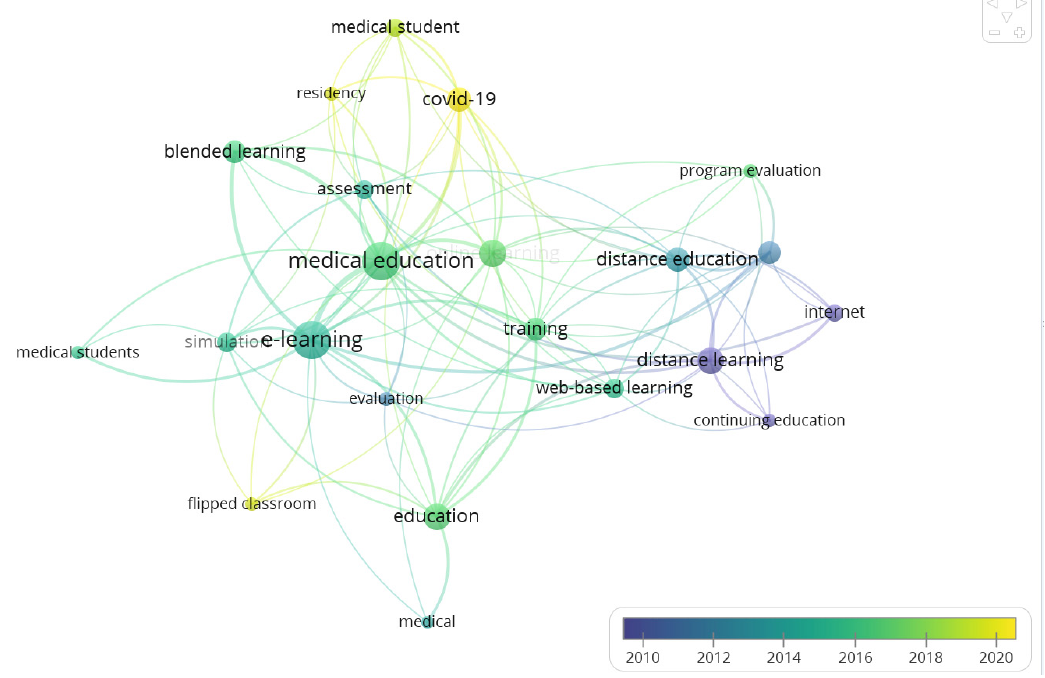
Figure 8. Overlay visualization map of the top 20 frequent author keywords.